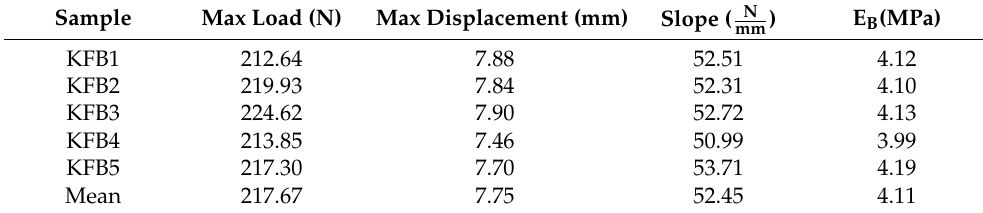
Table 5. Bending test results of Onyx™–Kevlar ® 3D-printed composites.